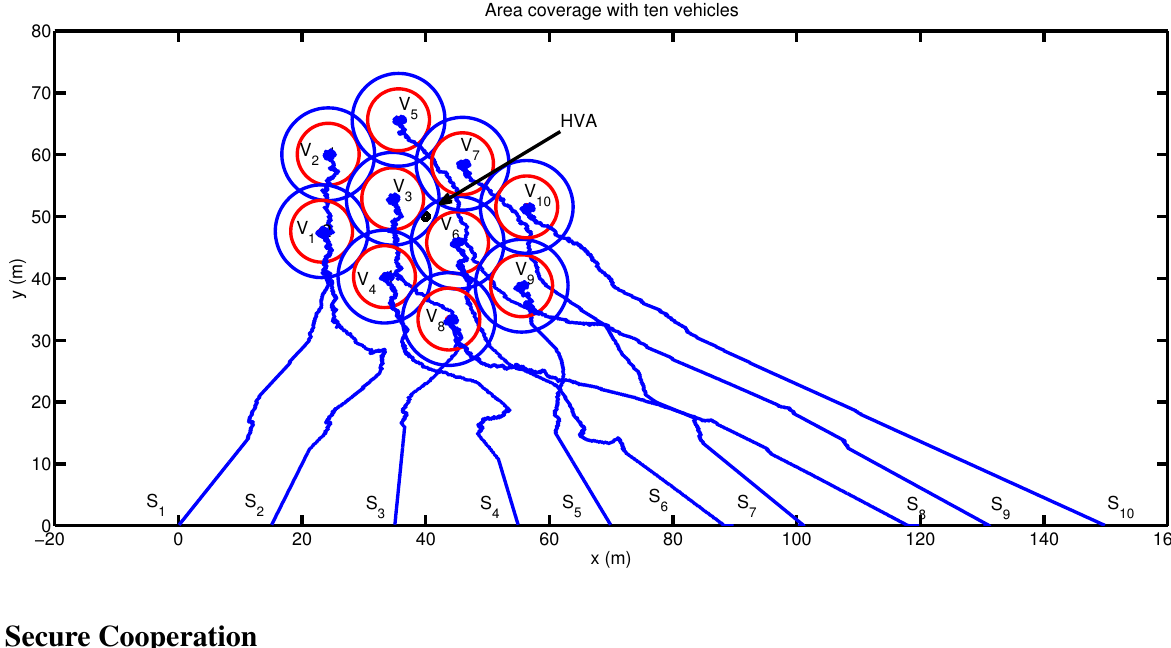
Figure 8. Area coverage performance with ten vehicles. The HVA is placed at the center of the sonars detection